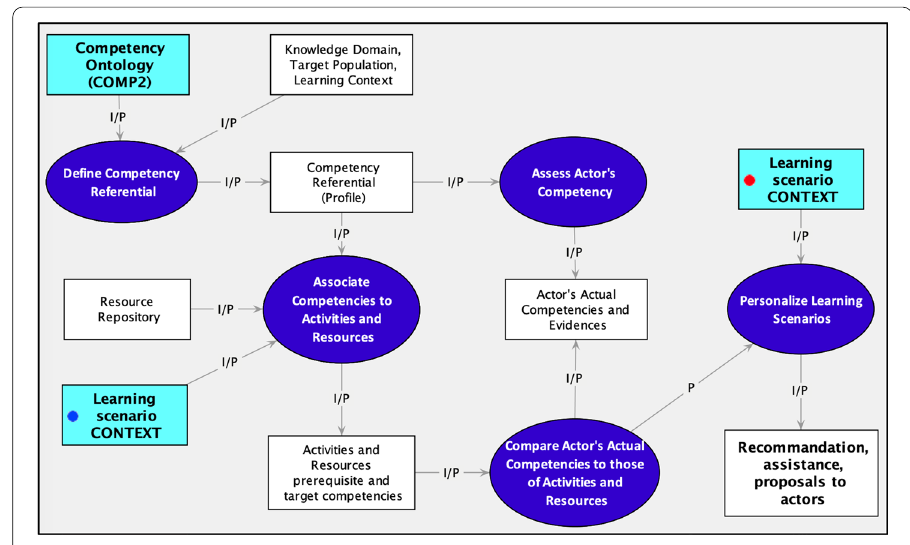
Fig. 8 The Competency-based personalization